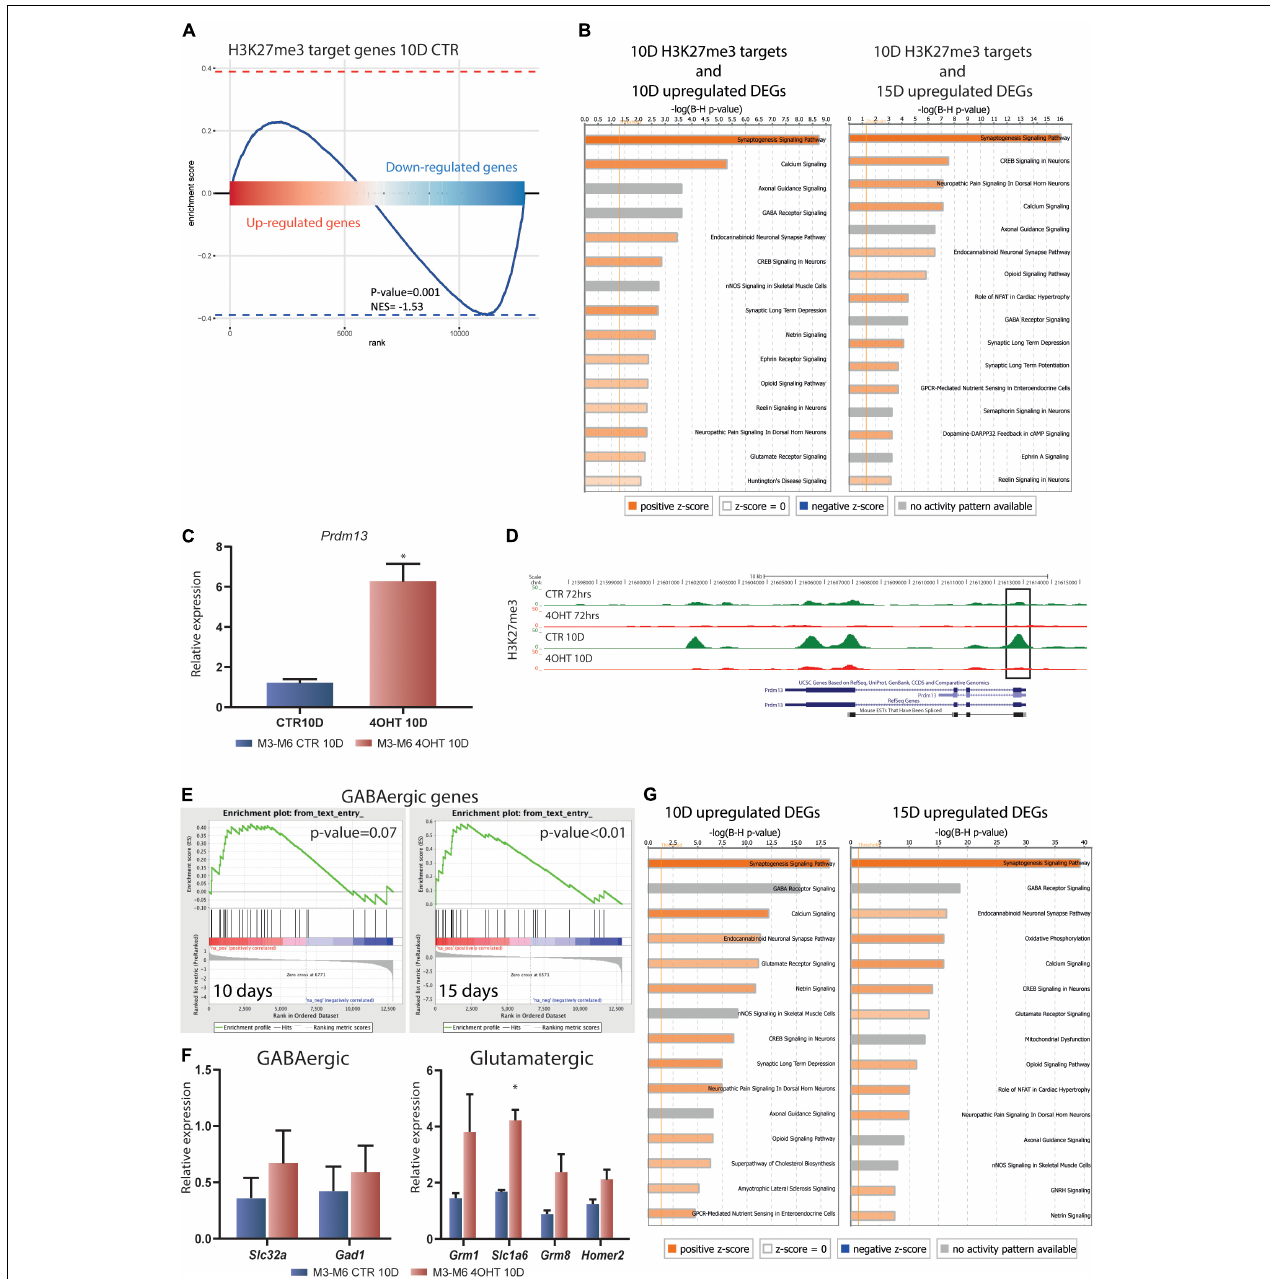
FIGURE 4 | Dissection of the transcriptional impact of Ezh2 deletion unveiled direct and indirect regulation of neuronal gene expression programs. (A) Enrichment plot showing the distribution of H3K27me3 targets in the ranked gene expression signature between treated and control samples at 10D. The blue curve represents the enrichment score, the bar in the middle represents the ranked gene expression signature between treated and control samples at 10D. Red and blue indicate up-regulation and down-regulation in the 4-OHT samples, respectively. The P -value (0.001) and normalized enrichment score (NES, –1.53) were computed using the fgsea algorithm (Litwin, 1976). (B) Canonical pathway analysis performed on the upregulated DEGs (FDR < 0.05) at 10D and 15D (left and right, respectively) found to be H3K27me3 targets in CTR10D. The top 15 pathways are shown. B-H multiple testing corrected p-values were computed using IPA software. (C) qRT-PCR validation of Prdm13 expression levels in 10D neurons. The experiment was performed on 2 independent biological replicates from 2 independent ESC lines carrying the Ezh2 flox / flox allele (M3 and M6) (mean ± SEM, unpaired t -test) ( ∗ : p value < 0.05). (D) H3K27me3 ChIP-seq tracks for the Prdm13 gene. Black rectangle highlights the peak on the TSS. (E) Gene set enrichment analysis showing the enrichment for GABAergic genes in the 4-OHT samples at 10D and 15D. (F) qRT-PCR validation of selected genes involved in the GABAergic and Glutamatergic pathways. The experiment was performed on 2 independent biological replicates from 2 independent ESC lines carrying the Ezh2 flox / flox allele (M3 and M6) (mean ± SEM, unpaired t -test) ( ∗ : p value < 0.05). (G) Canonical pathway analysis performed on upregulated DEGs (FDR < 0.05) at 10D and 15D (left and right, respectively). The top 15 pathways are shown. B-H multiple testing corrected p -values were computed using IPA